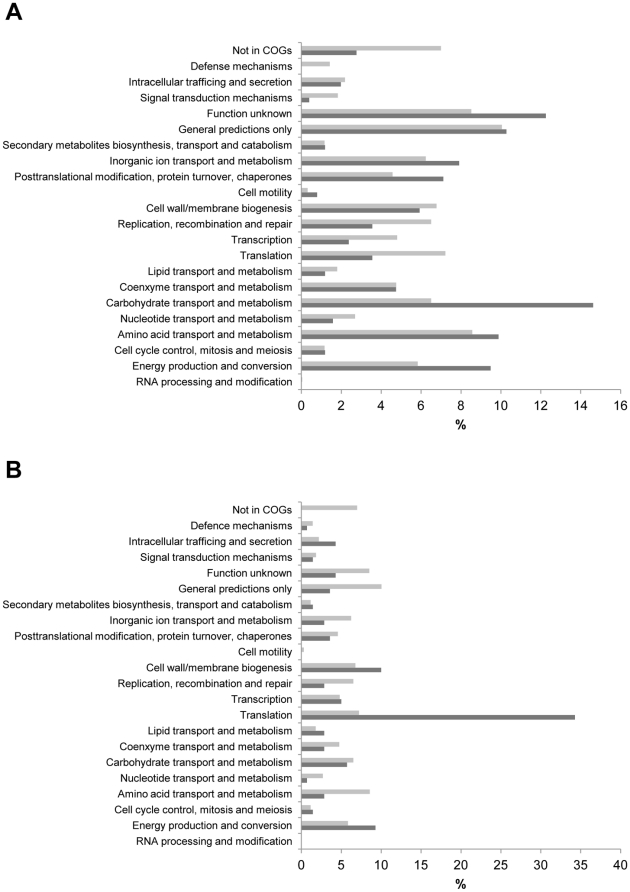
Distribution of in vivo regulated genes classified according to the Clusters of Orthologous groups (COGs).Dark bars: Functional distribution of differentially expressed genes (A) and constitutively highly expressed genes (B) in A. pleuropneumoniae during growth in pig lung in the acute phase of infection. Light bars: distribution of functional groups in the A. pleuropneumoniae genome.